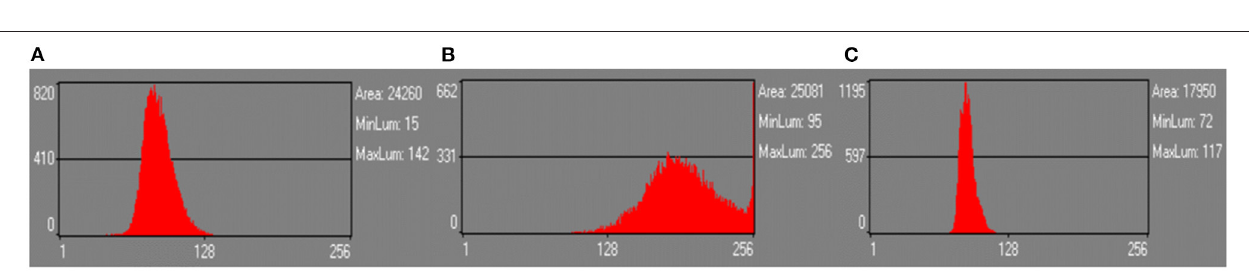
FIGURE 4 | The same case as in Figure 2 . (A–C) were the histograms of T2WI, ADC, and T1CE plots,